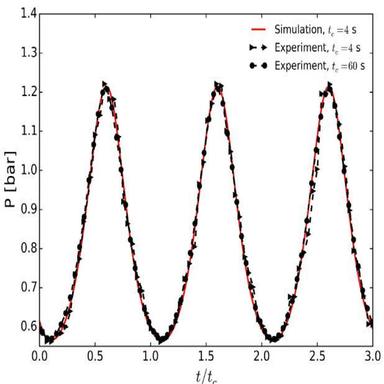
Experimental and simulated pressure profile for He in the empty column at two cycle times. The simulation for tc = 60 s overlaps the one for tc = 4 s. Conditions: T0 = 30 C; u ¼ 0:5p; Stroke1 = Stroke2 = 0–75 mm.